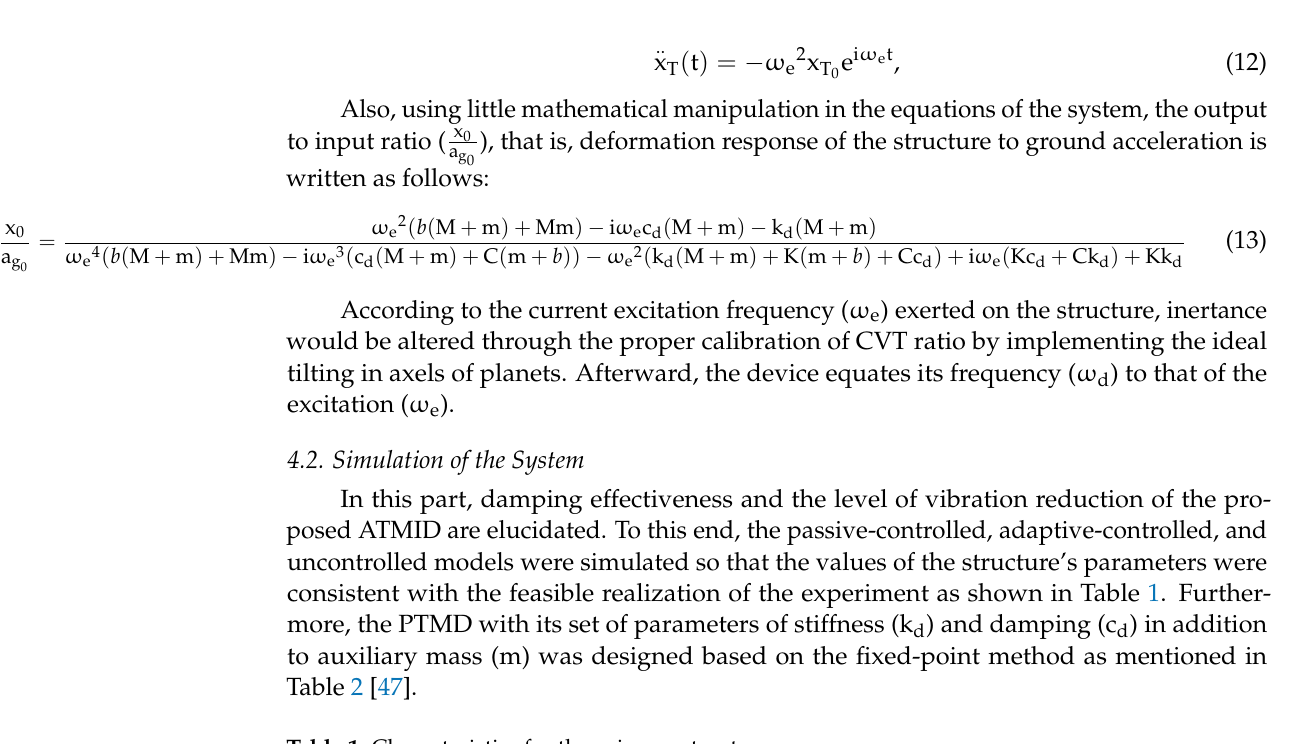
Table 1. Characteristics for the primary structure.